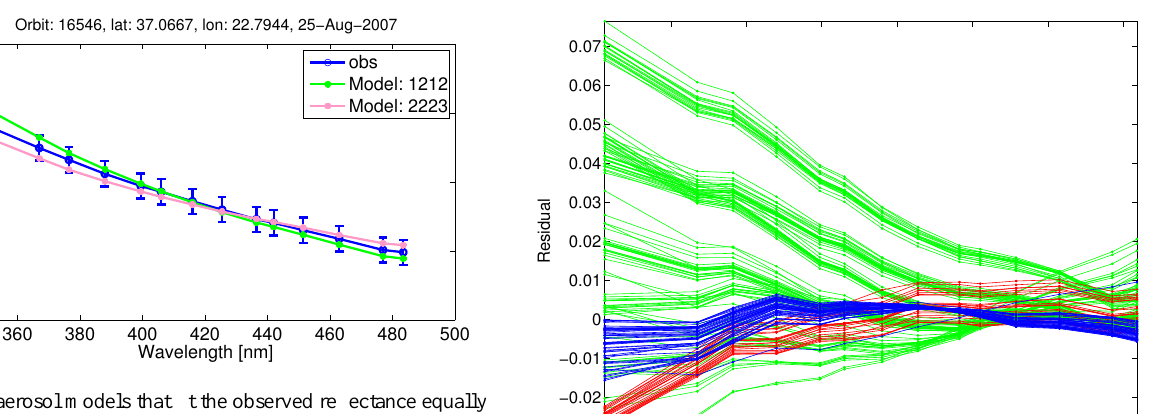
Fig. 1. Two aerosol models that fit the observed reflectance equally well.